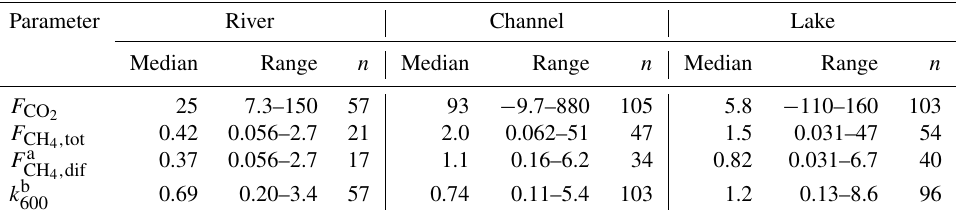
Table 2. Median and range of measured CO 2 and CH 4 fluxes (mmolm − 2 d − 1 ) and calculated k 600 values (md − 1 ). Additionally, n states the number of measurements. The range indicates the minimum and maximum observations.